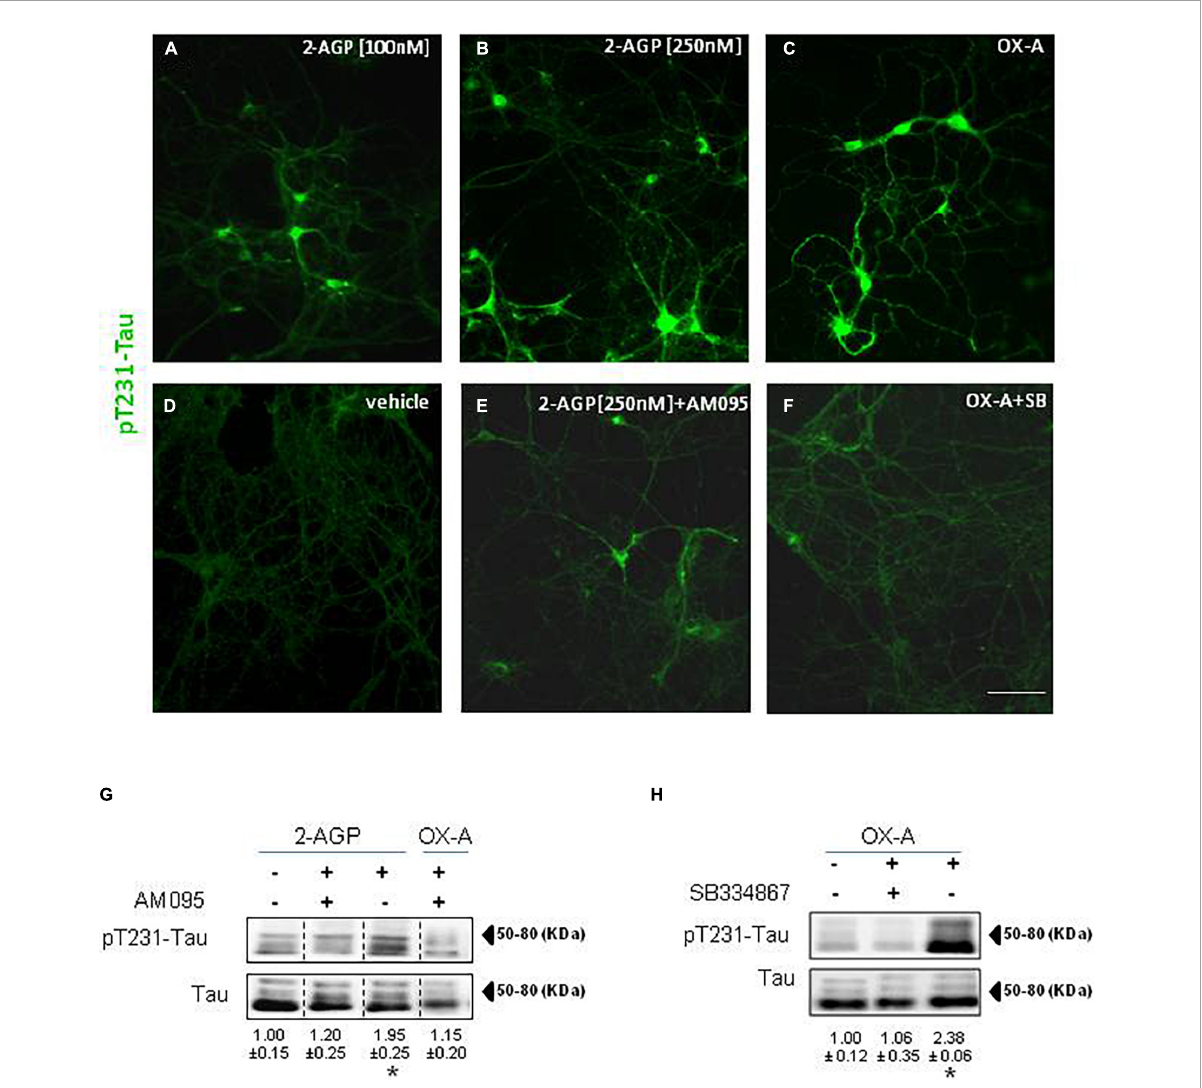
FIGURE3 Phosphorylation of Tau is induced by 2-AGP via OX-A and destabilizes microtubules of primary neuronal culture. (A–F) Representative images of pT231-Tau immunoreactivity in the primary neurons from mouse hippocampus under different experimental conditions show the highest expression in the soma and neural processes of cells treated with 2-AGP and OX-A that is blunted by incubation with the respective receptor antagonist AM095 or SB334867; Scale bar = 100 µ m. (G) Representative immunoblots of pT231-Tau/Tau ratios showing the effect of the 2-AGP or OX-A, with or without incubation with the LPA1R antagonist AM095 (10 µ M) of primary hippocampal neurons. Lanes from blots spliced together in a composite image are separated by a dotted black vertical line. Data are means ± SEM ( n = 3 mice/group). Optical density (OD) values are expressed as the ratio between the OD values of phosphorylated and total protein. Data represent means ± SEM, statistical analysis was performed by ANOVA followed by Tukey’s test. * p < 0.01. (H) Representative immunoblots of pT231-Tau/Tau ratios showing the effect of OX-A, with or without incubation with the OX-1R receptor antagonist SB334867 (10 µ M). Data are means ± SEM ( n = 3 mice/group). Optical density (OD) values are expressed as ratio between the OD value of phosphorylated and total protein. Data represent means ± SEM, statistical analysis was performed by ANOVA followed by Tukey’s test; * p <